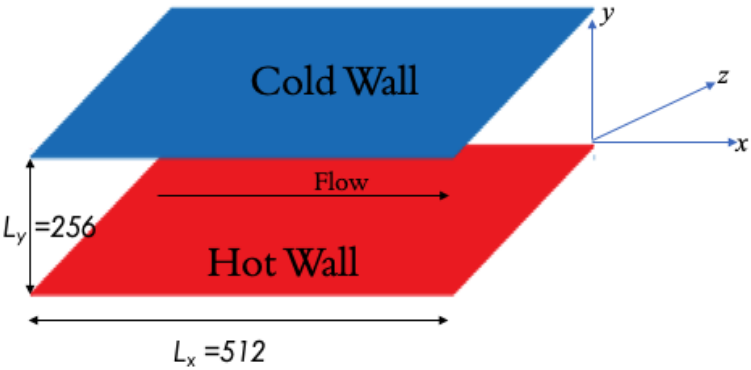
Figure 1. Simulation domain 512 × 256 × 512 grid points. The 2D snapshots of the streamwise velocity field and temperature field at the Z- centerplane in the domain are presented in Figures 2 and 3. In this flow configuration, the velocity and temperature signals were probed at the 128th grid point from the bottom hot plate.